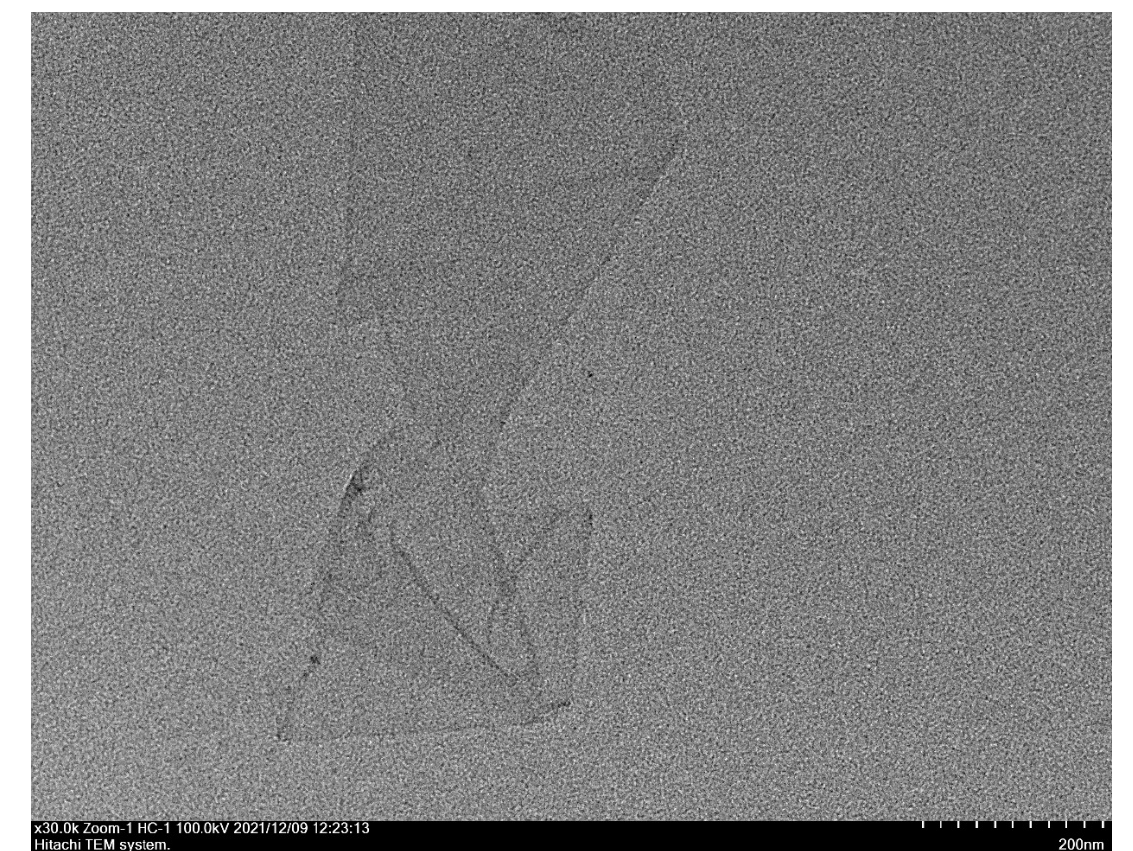
Figure 1. Transmission electron micrograph showing GO dispersion.